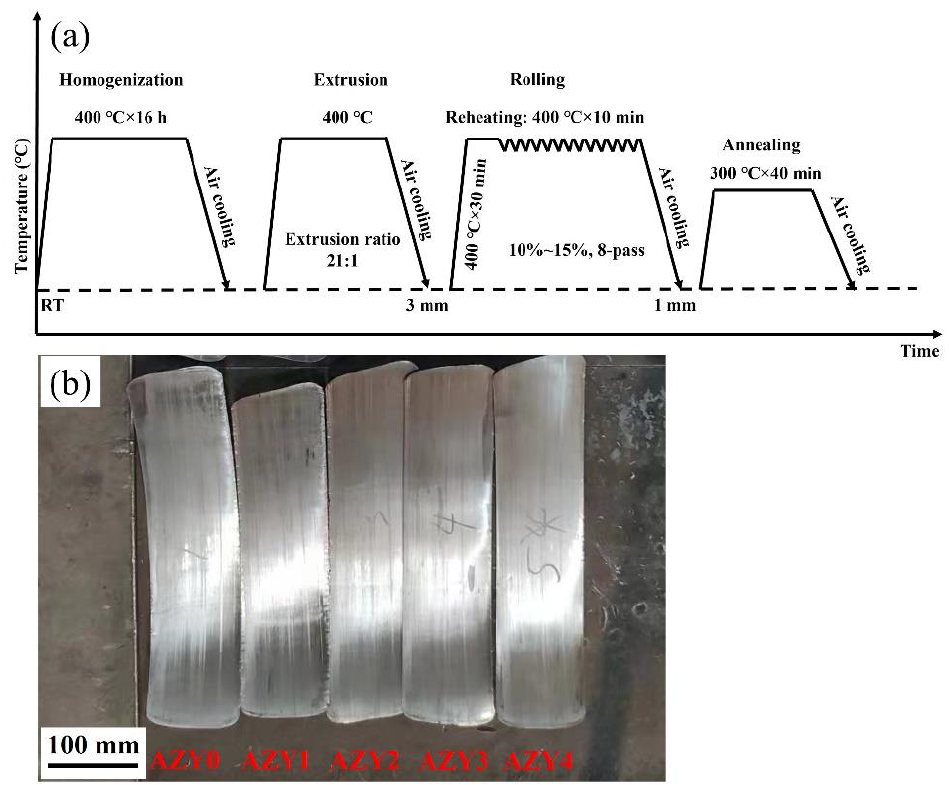
Figure 1. The schematic diagram showing the preparation process employed in the present study: ( a ) Schematic diagram; ( b ) Final rolled sheets. Five groups of samples with the compositions of AZ61-xY (x = 0, 0.3, 0.6, 0.9, 1.5 wt.%) were prepared in this experiment and numbered AZY0, AZY1, AZY2, AZY3, and AZY4 according to the above compositions, respectively. X-ray fluorescence spectrometer (XRF, MXP21VAHF, Japan) tests were carried out as shown in Table 1 for confirming the alloy composition. The microstructure was observed by optical microscope (OM, Carl Zeiss AG, Axio imager.A2m, German) and scanning electron microscope (SEM, Carl Zeiss AG, Zeiss supra55, German), respectively. The texture, grain orientation, and other microstructure data of the rolled sheets were collected and analyzed by electron backscatter diffraction (EBSD, Carl Zeiss AG, Zeiss supra55, German). The precipitated phases of the samples were observed by transmission electron microscope (TEM, FEI Company, TECNAI F20, American), and the TEM samples were prepared by ion milling method. A CMT4204 universal tensile testing machine (Mester, Shenzhen, China) was used to conduct tensile test on the samples, and three parallel samples were taken from each group to take the average value. The tensile tests were performed at room temperature, and the strain rate was 1